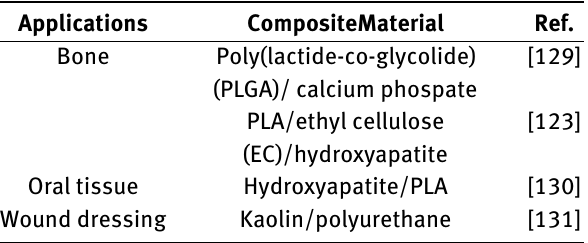
Table 9: Ceramic-polymer composites used in biomedical applica- tions Applications